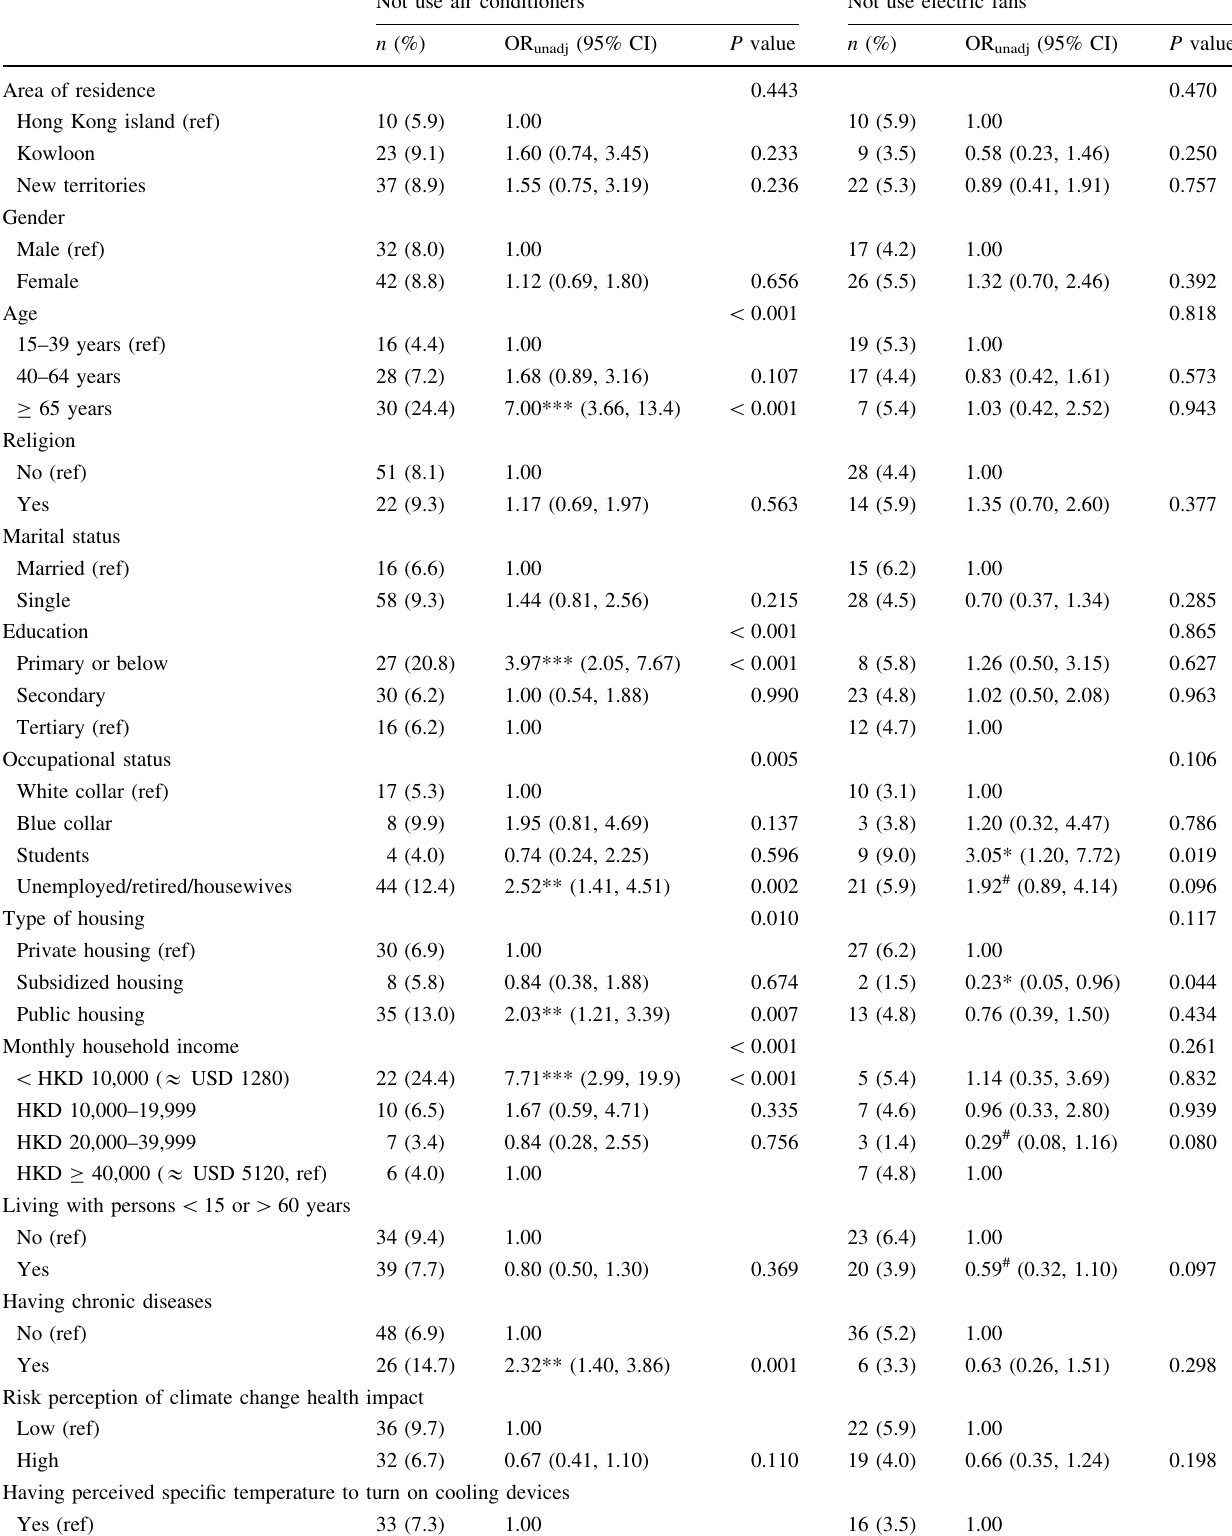
Table 6 Univariate logistic regression for use of cooling devices at home when feeling hot in the risk perception of climate change health impact survey in Hong